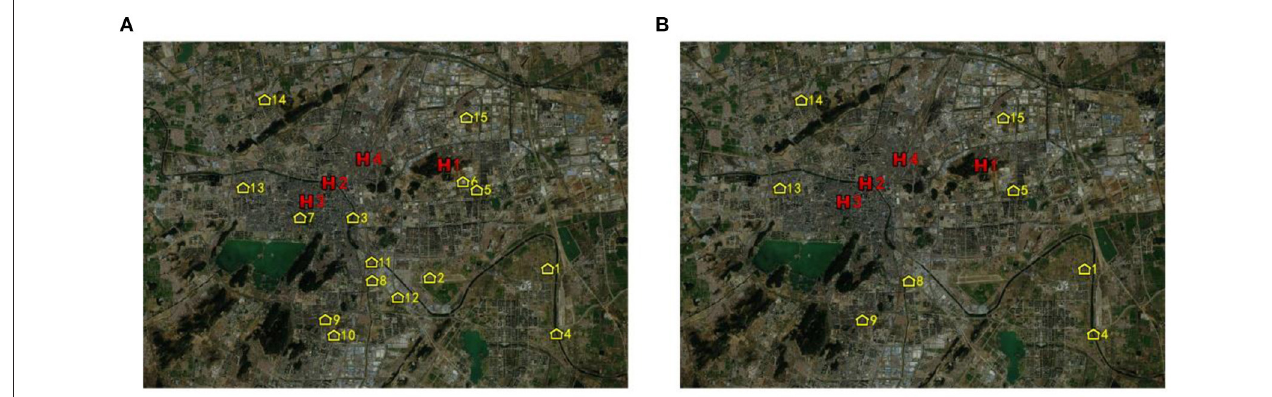
FIGURE 2 | Candidate Fangcang shelter hospital locations (A) before preliminary selection (B) after preliminary selection.